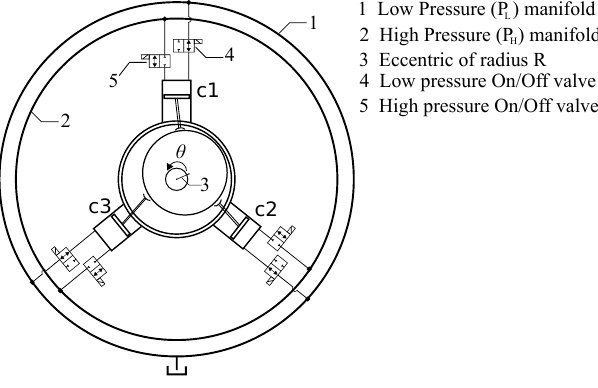
Figure 1: A DDM consisting of 3